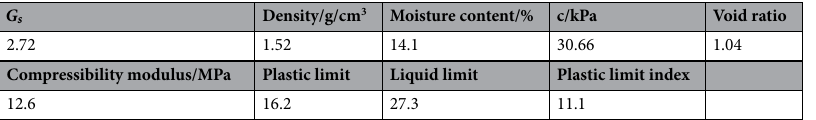
Table 1. Parameters of undisturbed loess.